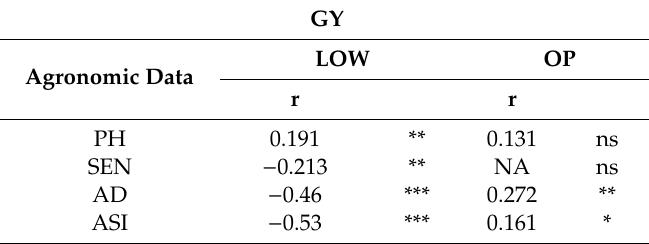
Table 5. Grain yield correlations with di ff erent indices of agronomic data, such as PH, SEN, AD, and ASI. Correlations were studied across plots in LOW and OP conditions. Levels of significance: *, P <